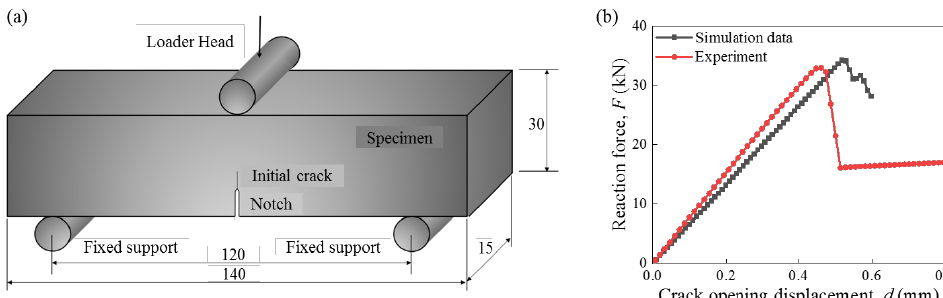
Figure 2. ( a ) Three-point bending test setups; ( b ) Comparison of the reaction force versus crack opening displacement between experiment and simulation.